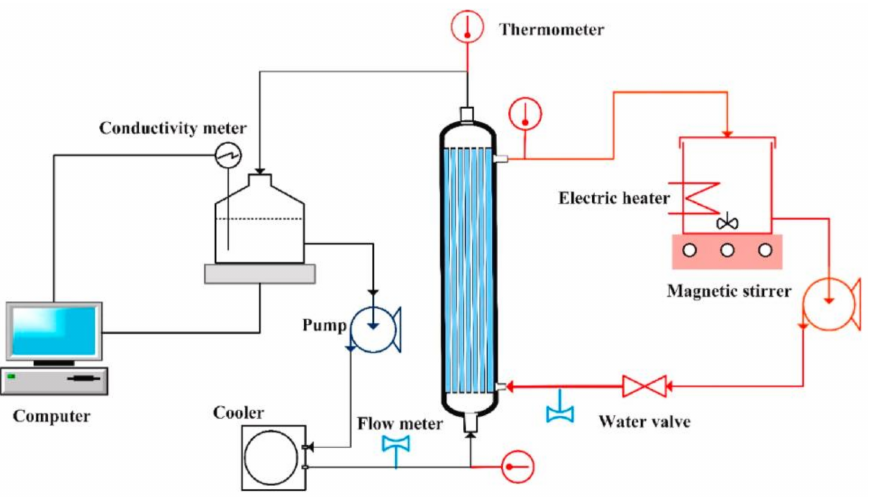
Figure 4. Schematic drawing of the apparatus for direct contact membrane distillation (DCMD) [25].